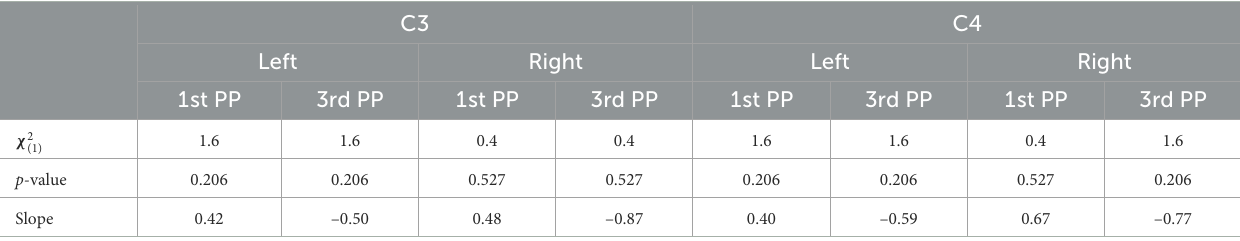
TABLE 3 Statistics obtained for the comparison between sessions in terms of Lateralization